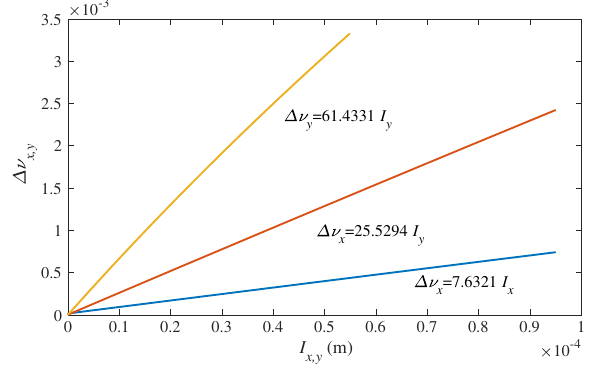
FIG. 18. Tune shifts due to different particle